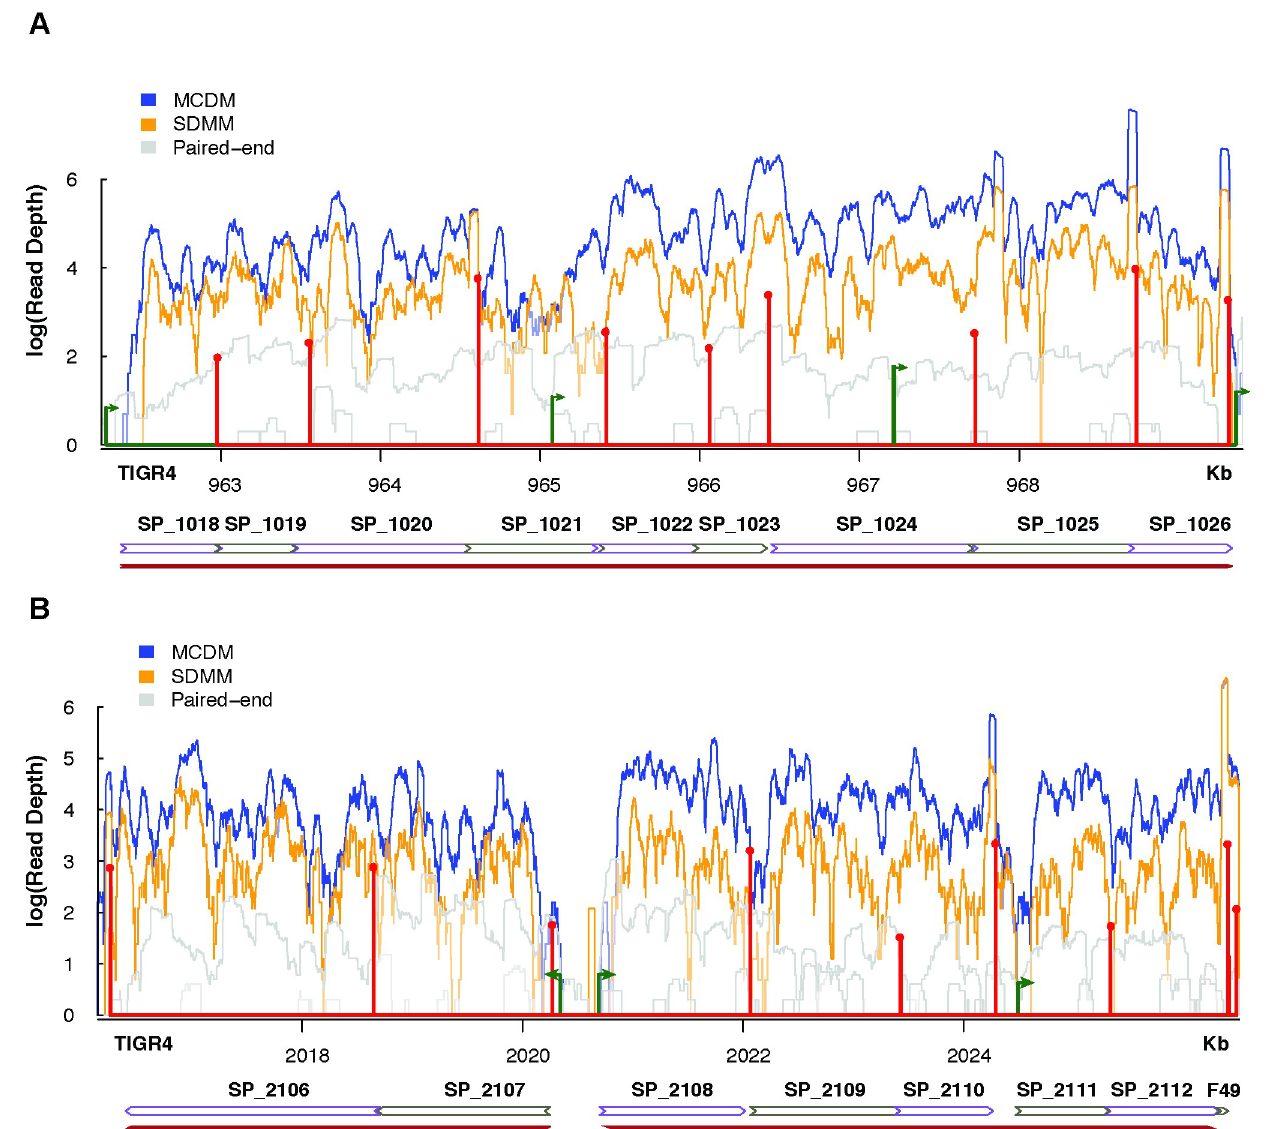
Fig 4. Variability in expression levels between genes in the same operon when grown in rich (SDMM) and poor (MCDM) media conditions. RNA-Seq coverage maps of complex operon/regulon including the TSSs in green and TTSs in red. Size of the transcriptional features represents log transformation of the processed/unprocessed ratio for TSSs and coverage for TTSs. Arrows on the TSS represent the strand and direction of transcription. There are little to no reads mapped to the strand opposite to coding regions. Coverage was normalized to the number of uniquely mapped reads in each library and log